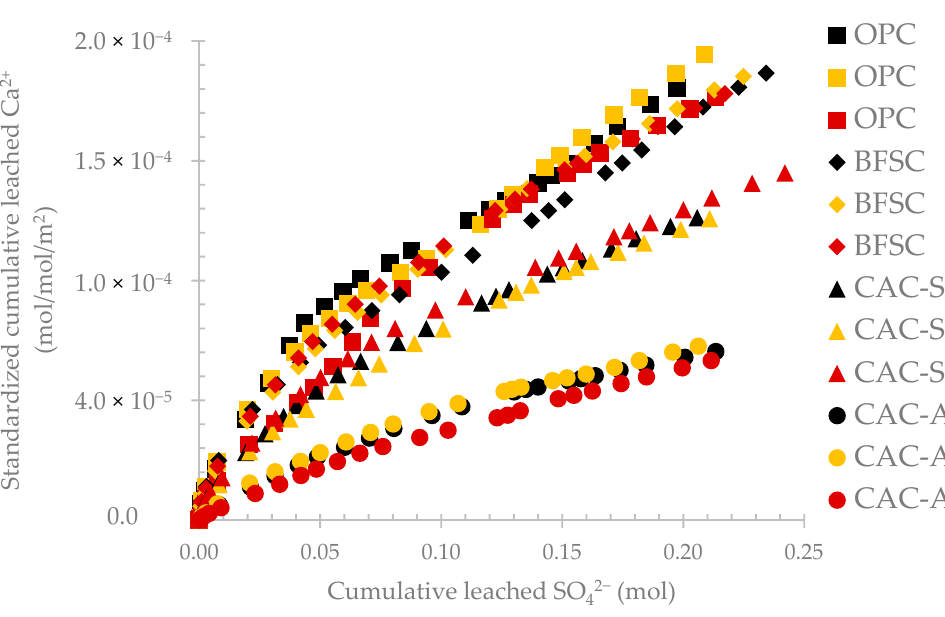
Figure 7. Evolution of standardized leached calcium per square meter as a function of the cumulative leached sulfate for the same testing campaign on four different materials Table 6. Error margins for materials tested in the same campaign. Error Margins (%) Property Materials